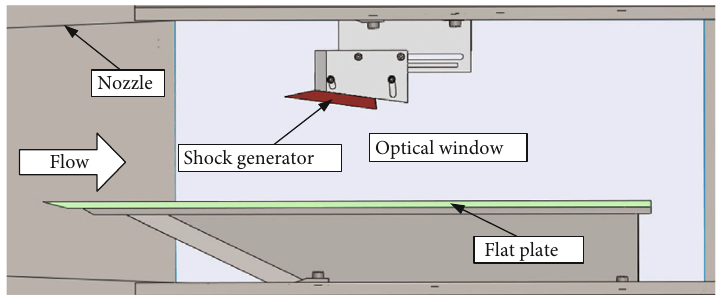
Figure 4: Experiment model in the wind tunnel.